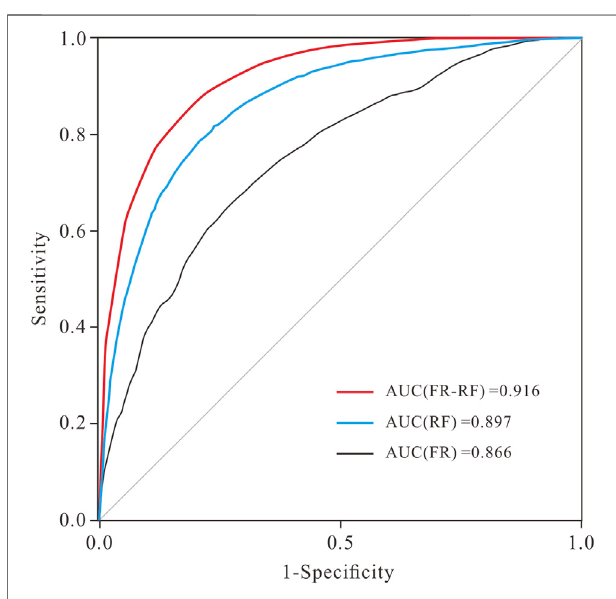
FIGURE 7 | ROCs of the FR, RF, and FR-RF